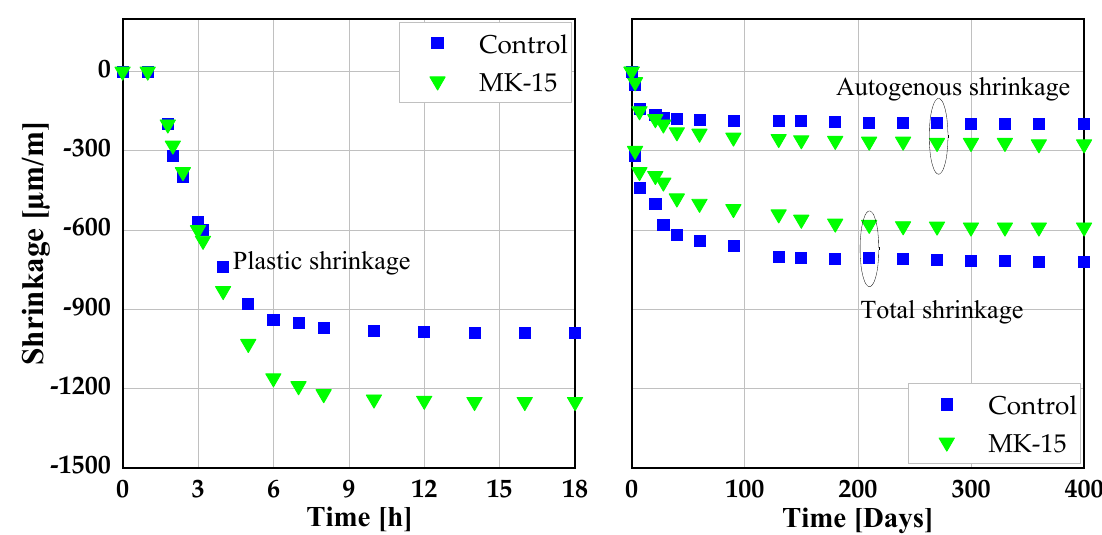
Figure 9. Plastic, autogenous and total shrinkage of concrete produced with metakaolin (MK) [120].